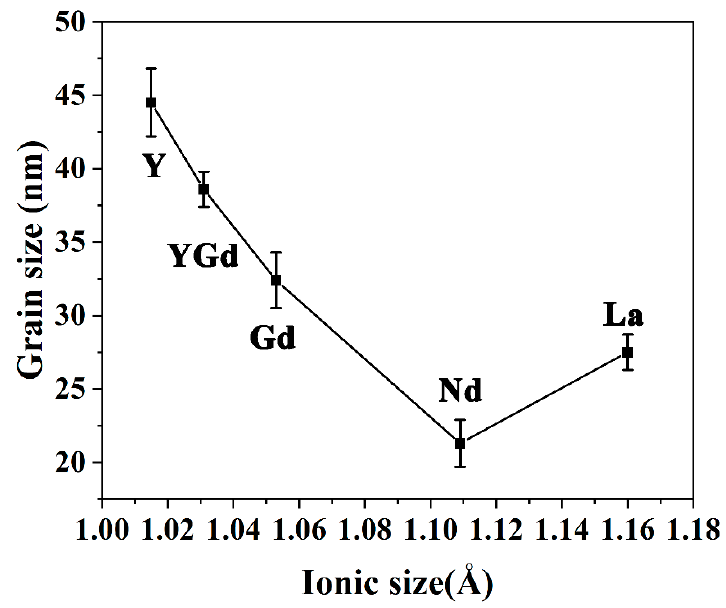
Figure 3. Average grain sizes of LnSZ after 6 h of heat treatment at 1100 ℃ .